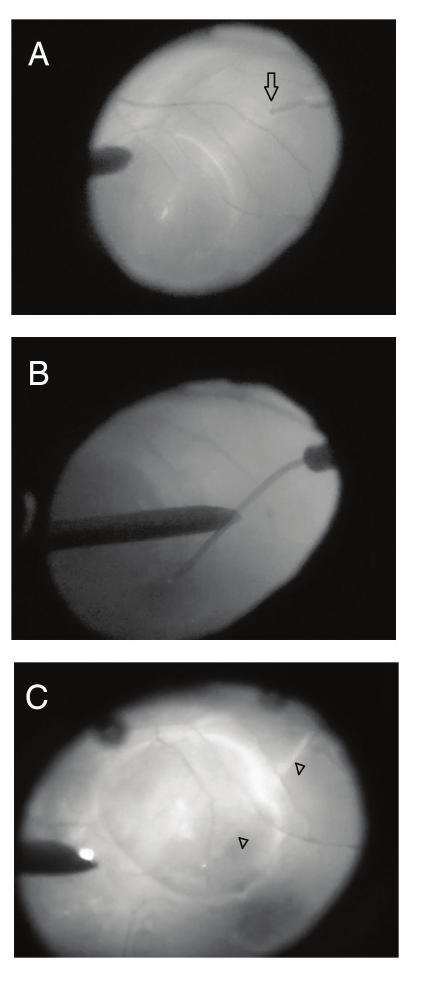
Figure 1. Essential surgical steps for the removal of submacular perfluorocarbon liquid (PFCL) using a 41-gauge extendible subretinal injection needle. (A) Artificial retinal detachment induction by slow injection of balanced salt solution (BSS) through the retinotomy incision near the inferotemporal arcade (arrow). (B) Bending the appropriate length of flexible needle with the aid of endoilluminator. (C) Active aspiration of PFCL bubble following needle entry into the subretinal space